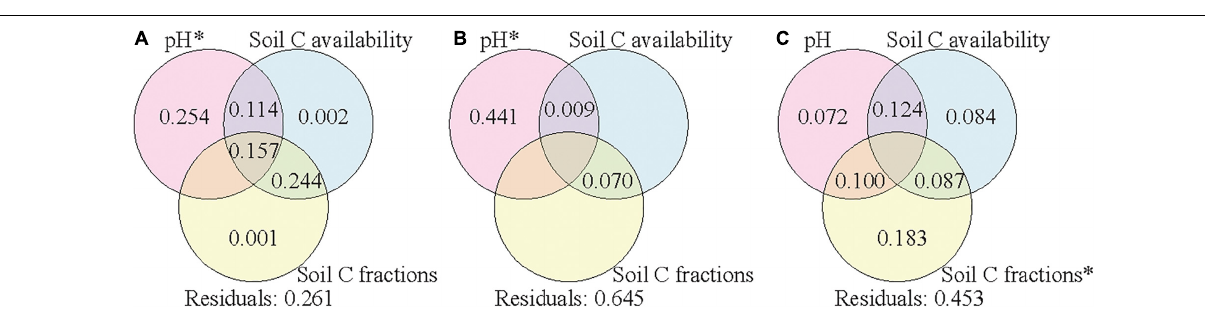
FIGURE 5 | Variation partition analysis of the effects of soil pH, soil C availability, and soil C fractions on soil bacterial community composition in the surface soil layer (A) , subsurface soil layer (B) , and deep soil layer (C) . Values < 0 are not shown. Significant values ( p < 0.05) after 999 permutations are indicated with an asterisk. Residuals mean the unexplained variation. Soil C availability includes variables of SOC content and the mole ratio of poorly crystallized Fe and Al to SOC (M o :SOC); soil C factions include variables of the labile carbon pool I (LPI%) and recalcitrant carbon pool (RP%). SOC, soil organic